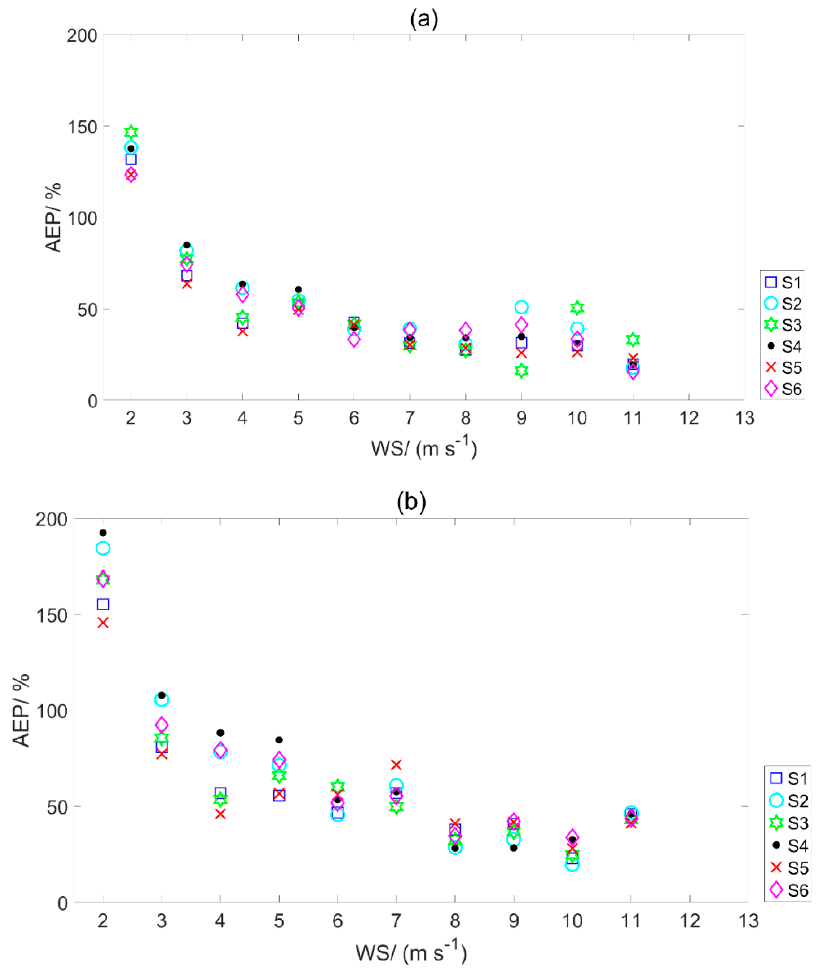
Figure 5. Same as Figure 3, but for Dunhuang station.Simulation result with ( a ) the global forecast system (GFS), and ( b ) the ERA5.